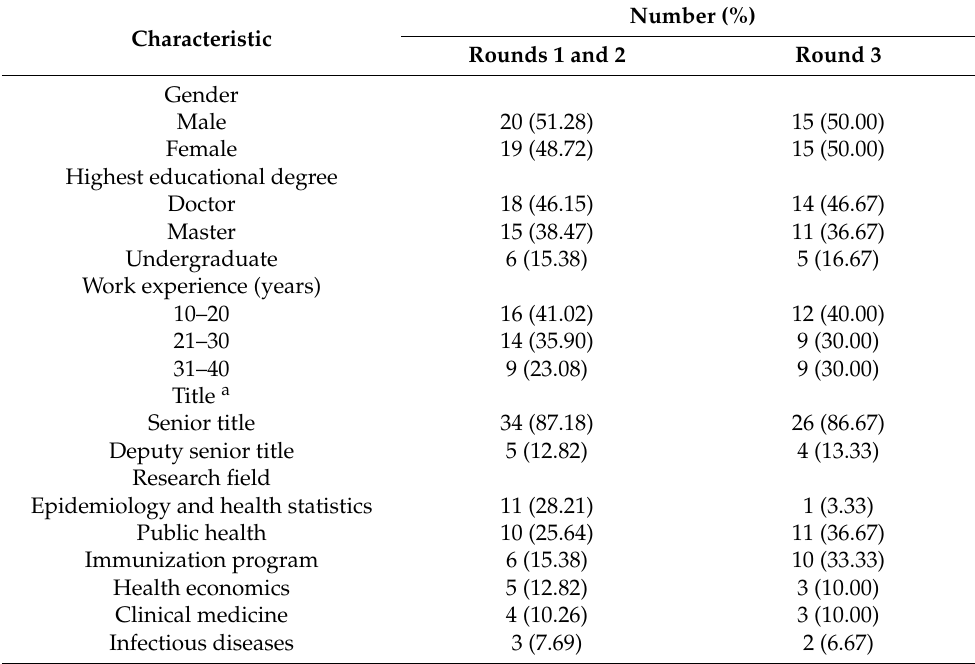
Table 1. Demographic characteristics of the